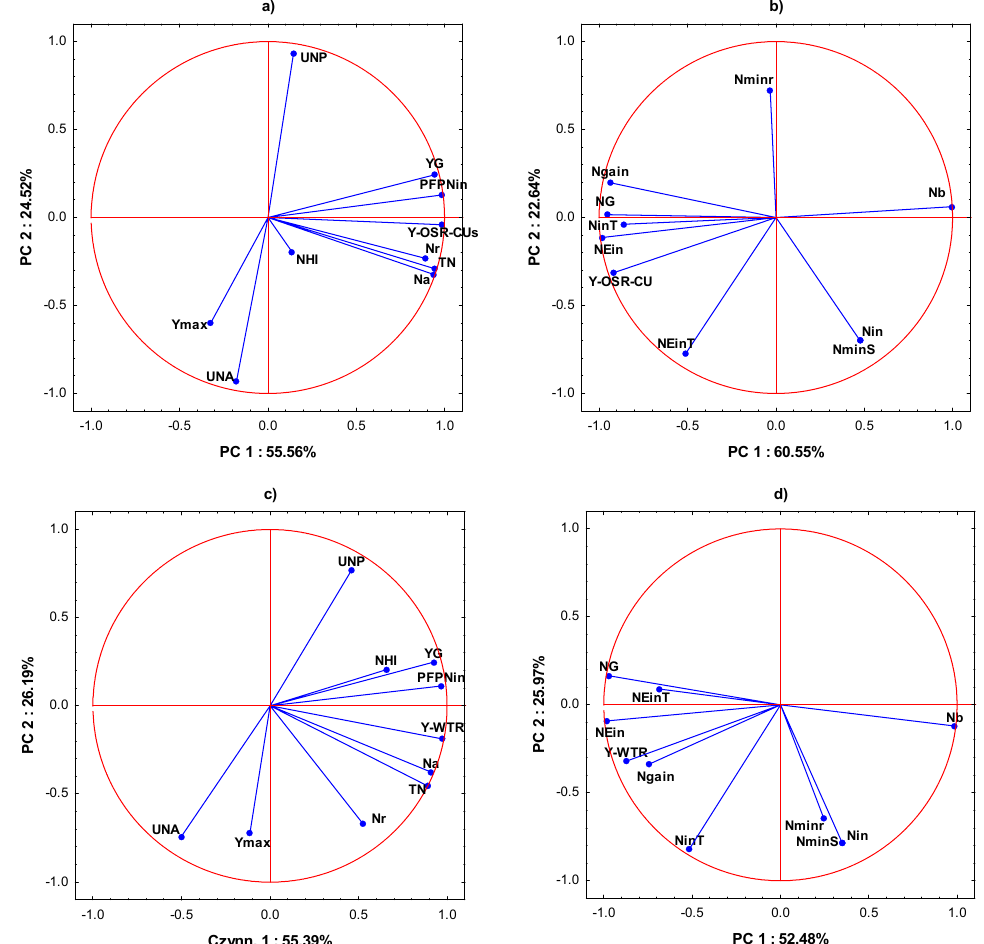
Figure 2. Score plot of yield parameters and nitrogen indices in first principal component (PC1) and second principal component (PC2) axes, ( a ) winter oilseed rape (WOSR)—crop N indicators, ( b ) WOSR—soil N indicators; ( c ) winter triticale (WTR)—crop N indicators; ( d ) WTR—soil N indicators. Yield parameters and crop indicators : Yield in cereals units; N a —N accumulated in seeds/grain; N r —N accumulated in harvest residues; TN—total N uptake by WOSR/WTR at harvest;